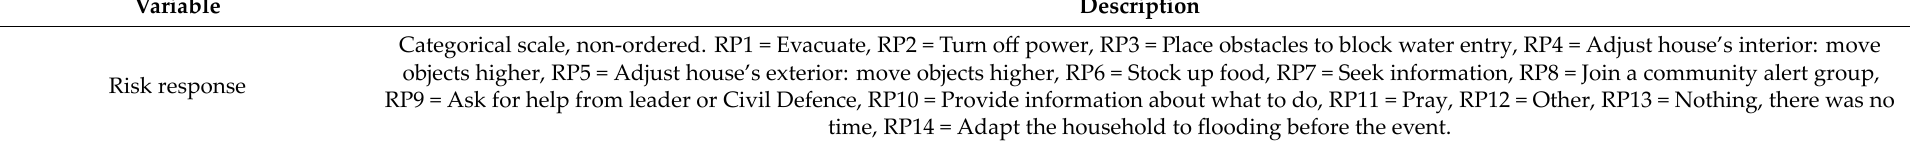
Table 1. Identification of variables for the study in the original